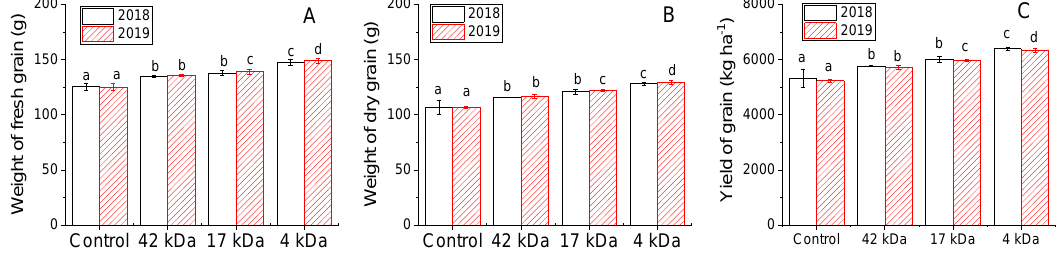
Figure 5. Influence of MWs on fresh ( A ) and dry ( B ) grain weights per ear and yield of grain ( C ) collected in 2018 and 2019. Bars represent mean values of three replicates ± standard deviation. Different letters indicate significant differences ( p < 0.05).